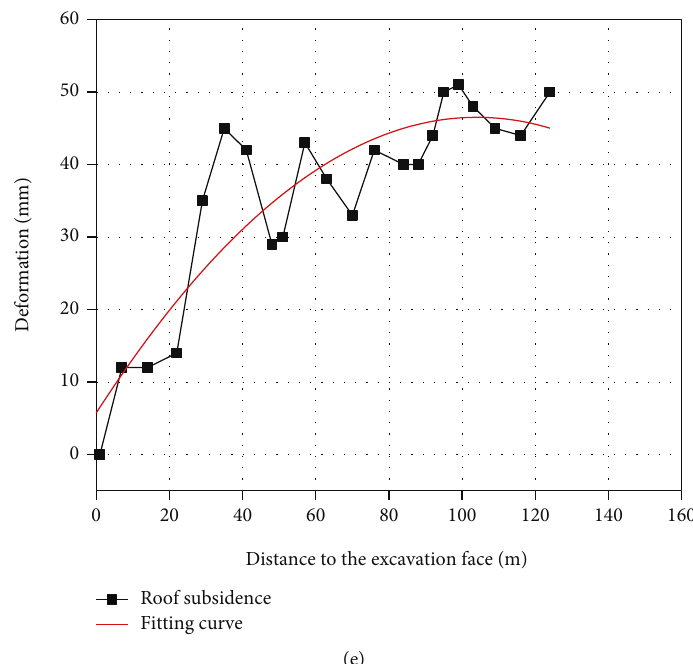
Figure 14: Monitoring results of roof subsidence.